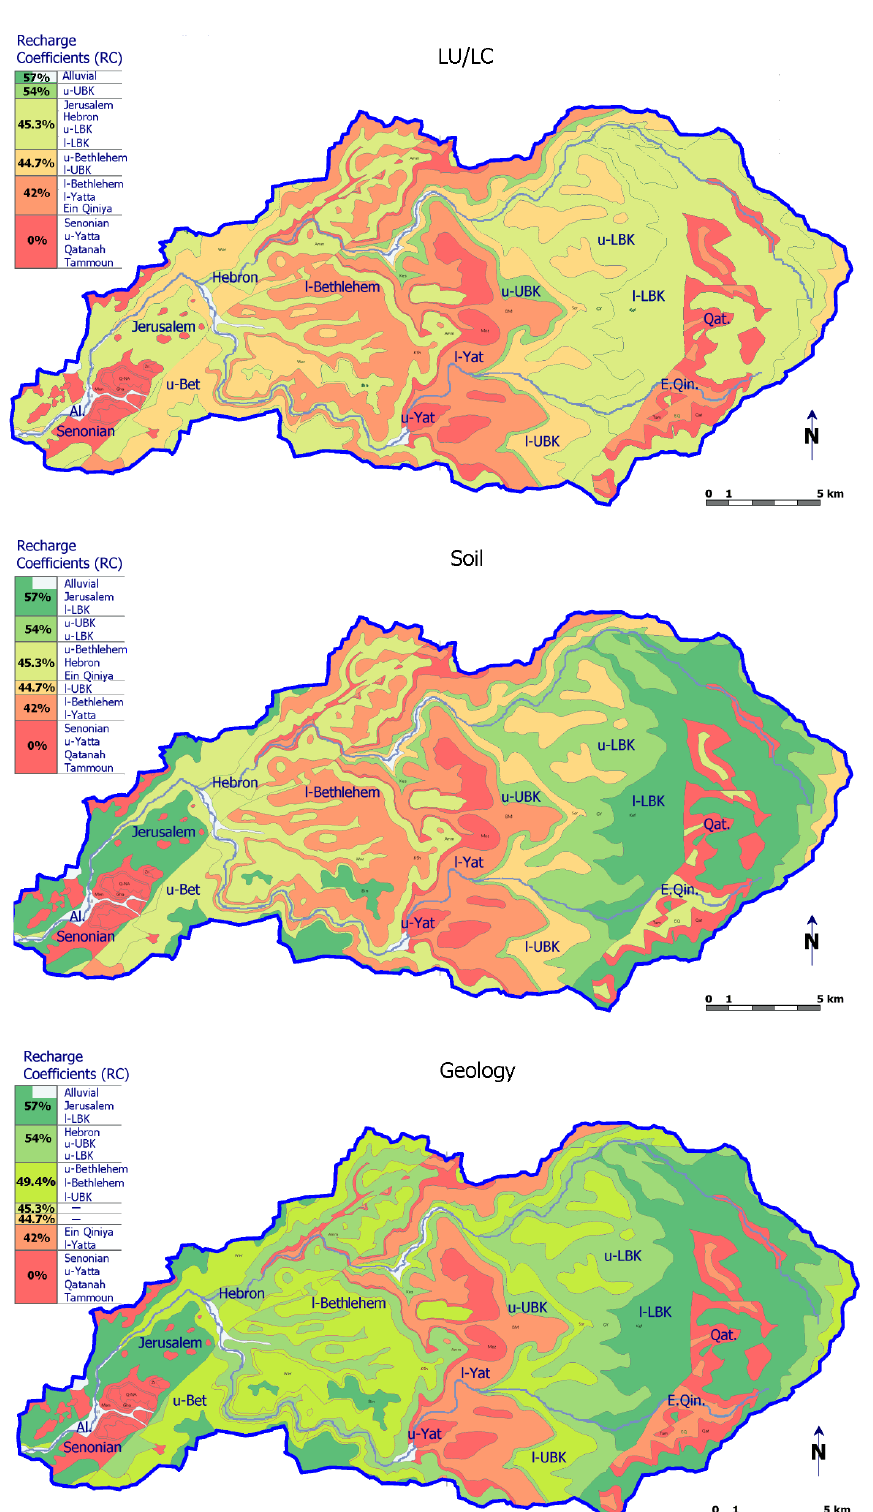
Figure 5. Recharge map of Wadi Natuf – recharge coefficients of the different formations according to the different groups of landscape characteristics (LU/LC, soil and geology). The RC values are shown in percent of annual precipitation.